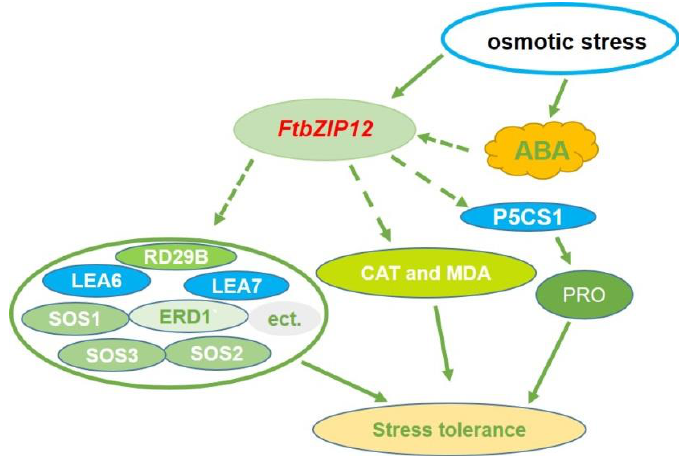
Figure 8. Working model of the mechanism of FtbZIP12 in improving osmotic stress tolerances. FtbZIP12 may improve Tartary buckwheat stress resistance by regulating related downstream stress genes, the SOS pathway gene, and the P5CS1 -driven proline synthesis pathway. Solid arrows indicate proven pathways whereas the dashed arrows show speculative pathways that remain to be confirmed.